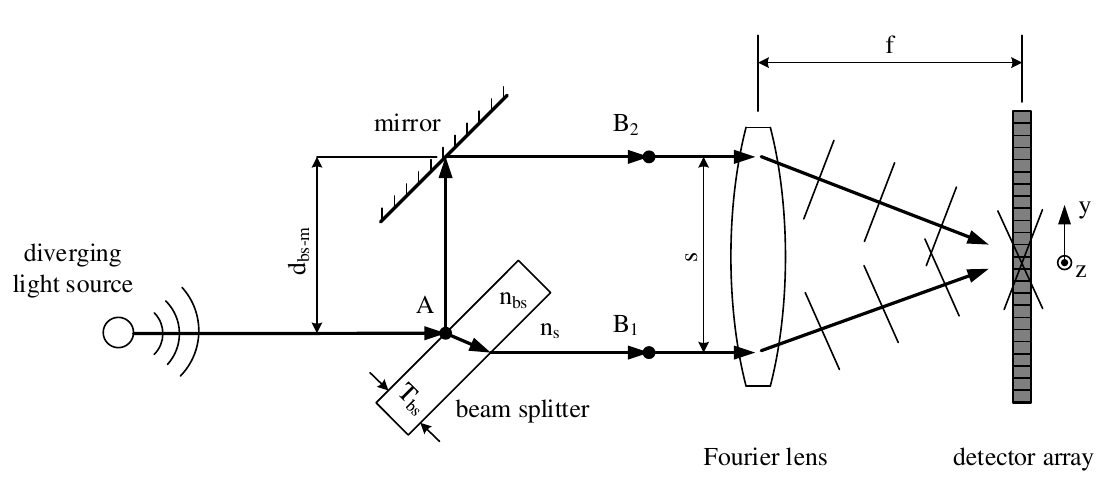
Figure 1. Schematic overview of a static single-mirror Fourier transform spectrometer